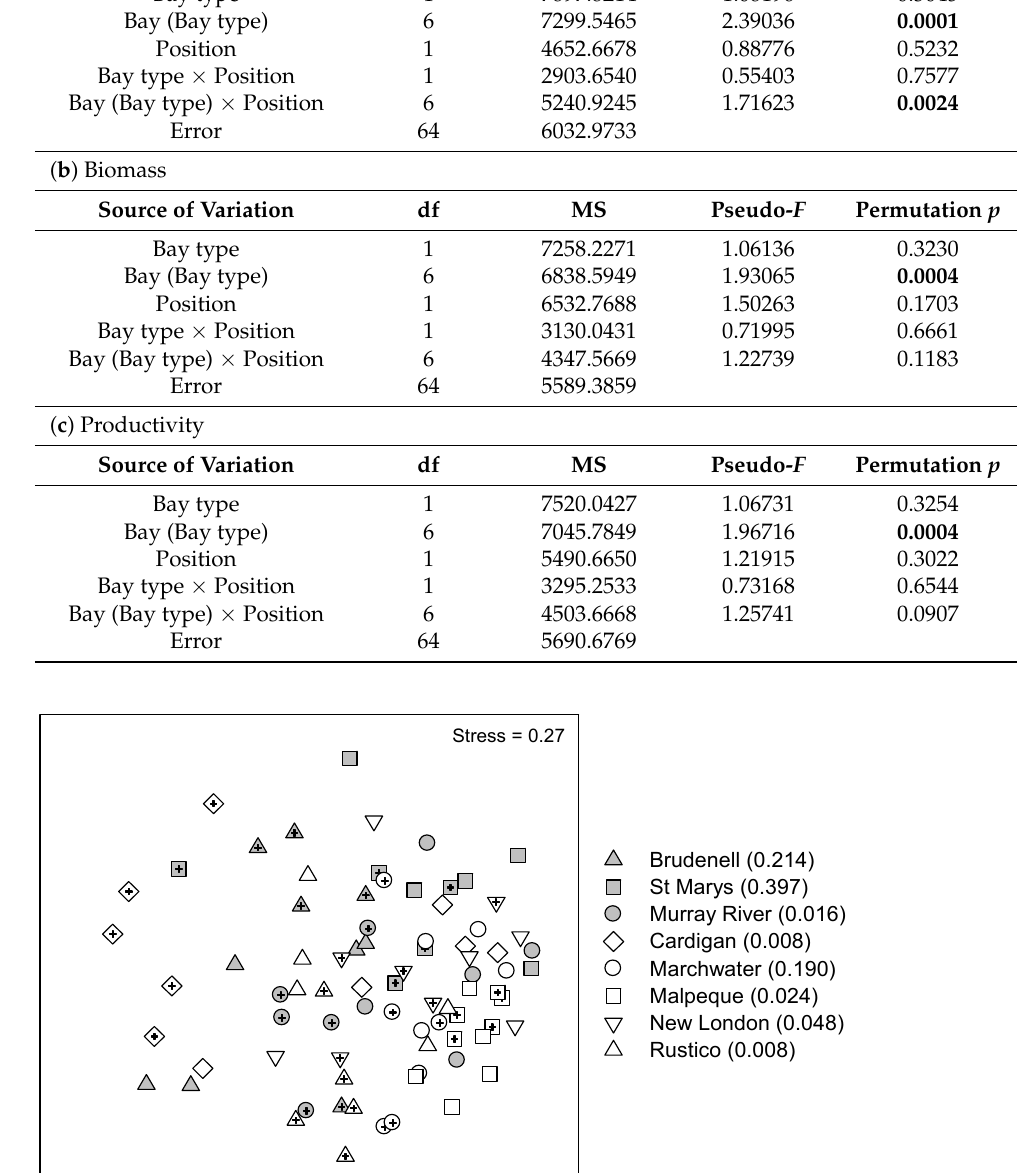
Figure 4. nMDS plot of variation in sediment macroinvertebrate community structure in 8 bays on PEI. Figure shows pattern for abundance data using a zero-adjusted Bray–Curtis dissimilarity coefficient to calculate dissimilarity among samples ( √ -transformed). Filled symbols indicate samples from bays infested by Styela clava , open symbols indicate samples from bays without S. clava . Samples from inside mussel leases are indicated with +. Multivariate patterns were similar for biomass and productivity of sediment macroinvertebrates and thus, for brevity, are not shown. Numbers in parentheses following site names indicate significance of pairwise contrasts comparing benthic assemblages from within mussel leases to those outside of them within that site.